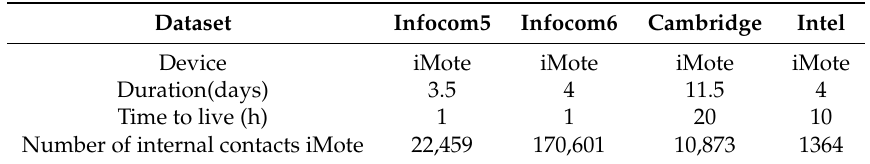
Table 1. The characteristics of the four mobility model in simulation environment.